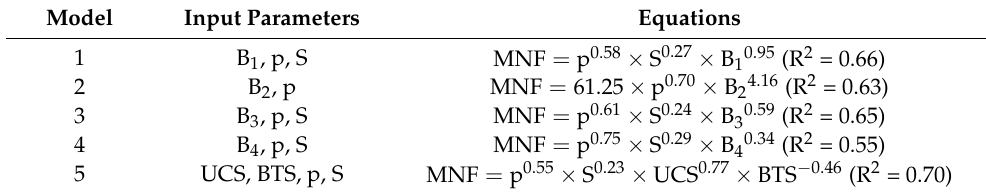
Table 5. Prediction models for normal cutter